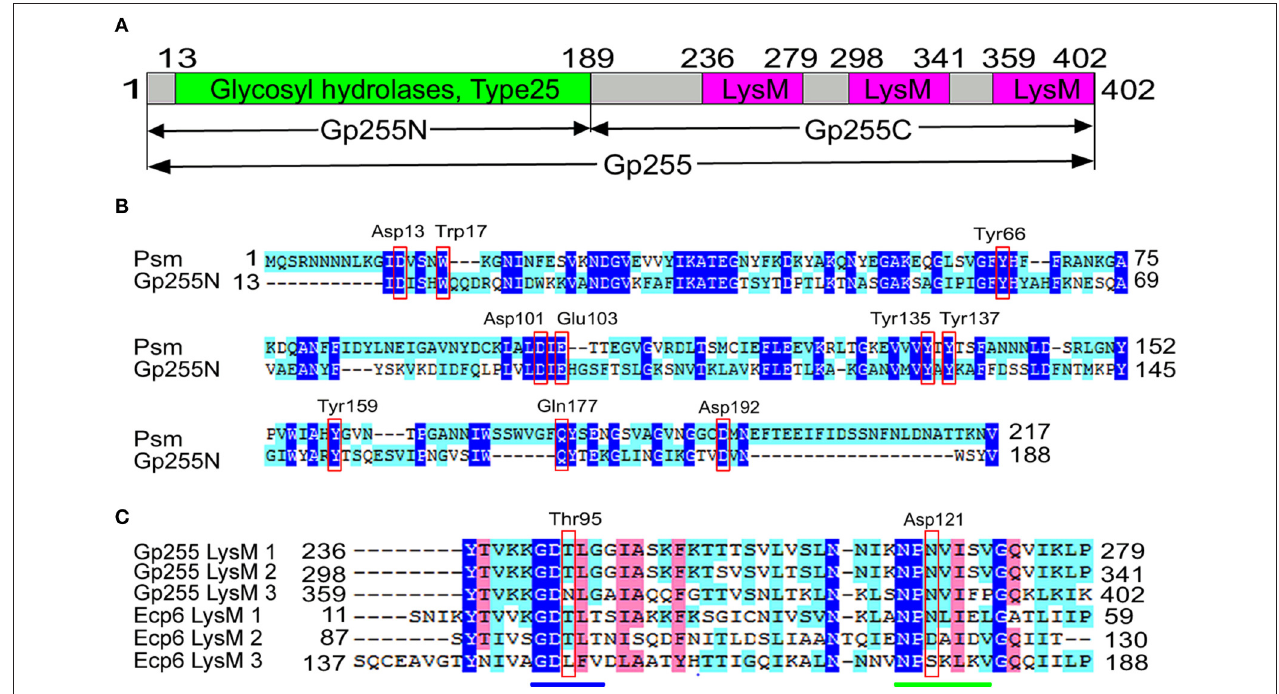
FIGURE 2 | Schematic diagram of Gp255 and amino acid sequence alignment of the LysM domains. (A) The domain composition of Gp255 analyzed by using Pfam and the positions of the amino acid residues at the end of each domain are indicated. The N-terminal catalytic domain and C-terminal cell wall binding domains are shown. (B) Alignment of the catalytic domain of Gp255 and endolysin Psm (PDB database accession number 4KRU_A) from phage phiSM101. The catalytic site residues of endolysin Psm are indicated in red box. (C) Alignment of the amino acid sequence of the three LysM domains from Gp255 and the three LysM domain from fungal efector Ecp6 (PDB database accession number 4B8V_A). The positions of the three peptides in Gp255 and Ecp6 are indicated. The two chitin-binding sites in LysM1 and LysM3 of Ecp6 are indicated with a blue line and a green line. The chitin-binding sites of LysM2 of Ecp6 are indicated in red box. The sequences were aligned by ClustalW